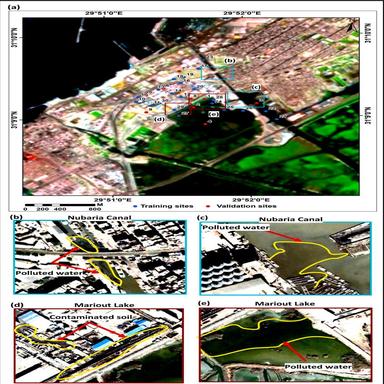
(a) Landsat 8 image in 2018 showing ground truth sites (i.e., thirty sites). (b and c) GE images showing oil-contaminated water at Nubaria Lake. (d and e) GE images showing oil-contaminated soil and water, respectively, at Mariout Lake zone. Note, the red points No. 1 to 9 refer to validation water/land samples from nine sites (Fig. 3a). (For interpretation of the references to color in this figure legend, the reader is referred to the web version of this article.)